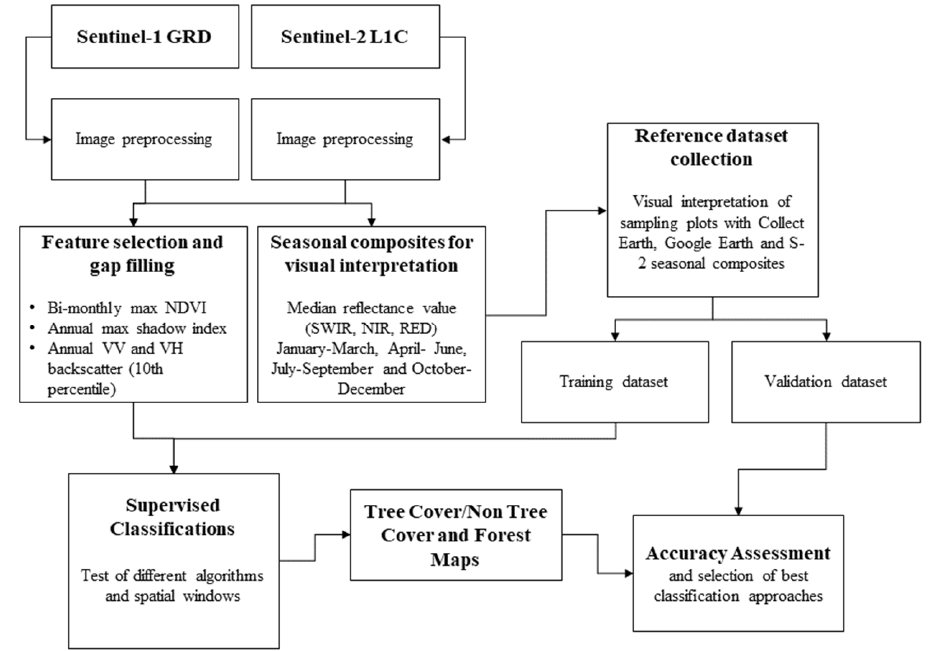
Figure 2. Workflow diagram of the main methodological steps.